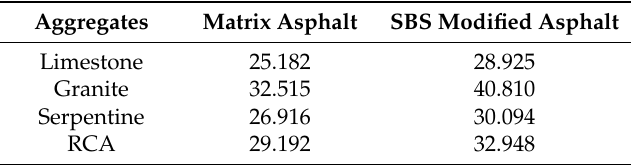
Table 8. CA between liquid asphalt and